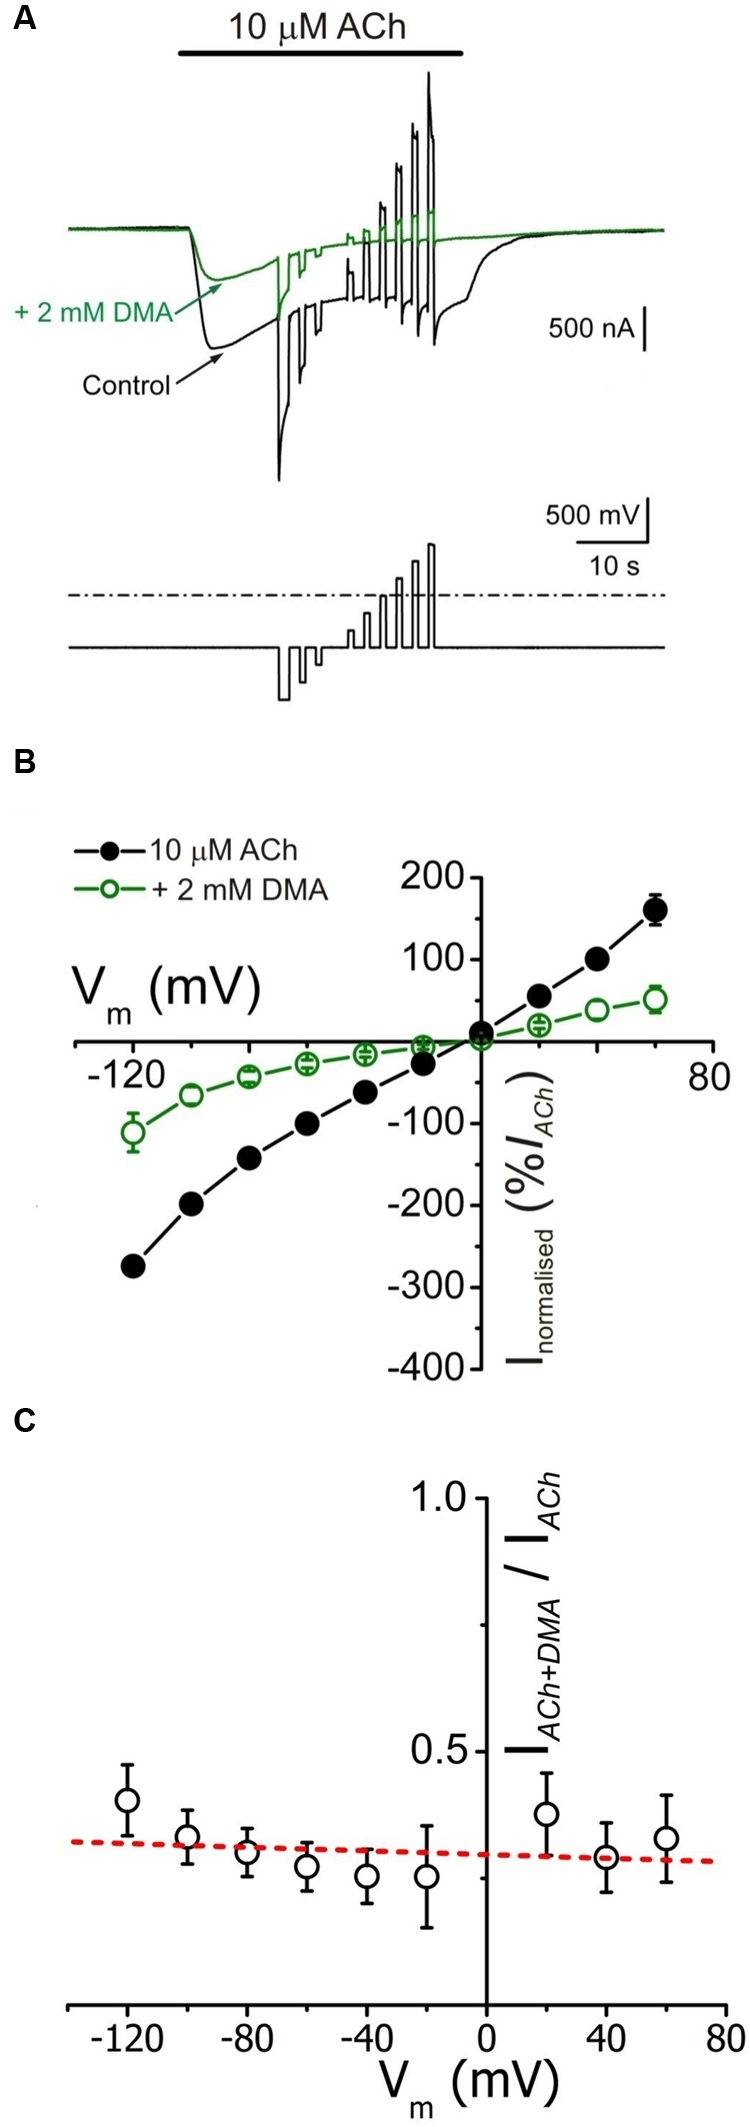
IACh blockade by DMA lacks of voltage dependence. (A) Whole membrane currents (upper traces) evoked by applying to an oocyte the voltage protocol shown on bottom, during the current plateau elicited by 10 μM ACh, either alone (black) or with 2 mM DMA (green). (B) Net i/v relationships for IACh, obtained by applying the voltage protocol shown in (A) while superfusing the cells with 10 μM ACh either alone (black filled circles) or co-applied with 2 mM DMA (green open circles). Values represent the percentage of current referred to their control IACh at -60 mV; each point is the average of 5 cells (N = 3). (C) Plot showing the fraction of plateau IACh left by 2 mM DMA (IACh+DMA), normalized to its control (IACh), versus the membrane potential. Same cells than in (B). Note the lack of a clear voltage dependence of IACh blockade by DMA. The dashed red line shows the best linear fit to the data; the fitted line has a correlation coefficient of -0.21, giving a p of 0.58 (the probability for the t-test of the slope = 0).